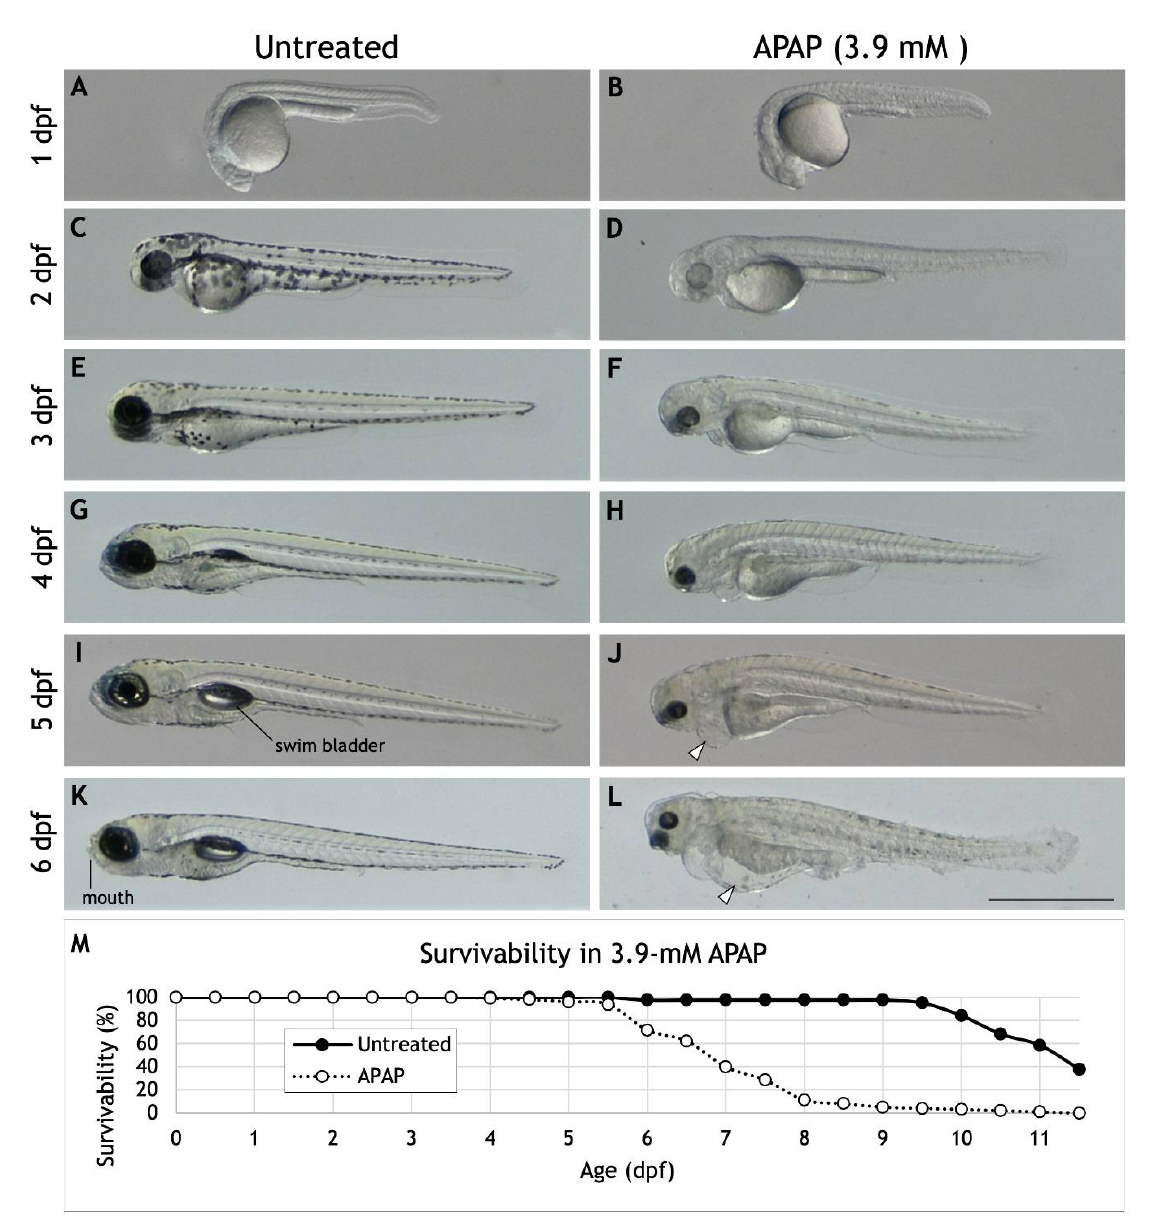
Figure 1. Morphology and survivability of APAP-treated larvae. ( A – L ) Lateral views of a single, representative larva either untreated ( A , C , E , G , I , K ) or continuously treated with 3.9-mM APAP from 2 hpf ( B , D , F , H , J , L ). Previously reported abnormalities visible here include reduced pigmentation, deformed tail and fin, failure to inflate swim bladder (compare ( I ) and ( J )), peritoneal edema (arrowhead in ( J )), and pericardial edema (arrowhead in ( L )). Note the absence of a visible jaw or mouth in the APAP-treated larva (compare ( K ) and ( L )). Many other larvae (not shown) also exhibit reduced body length and severe spinal curvature as reported elsewhere. Scale bar (in ( L )) for ( A – L ), 1 mm. ( M ) Survivability of untreated larvae ( n = 88) and larvae continuously treated with 3.9-mM APAP from 2 hpf ( n = 98). The longest-lived treated larva survived until 11.5